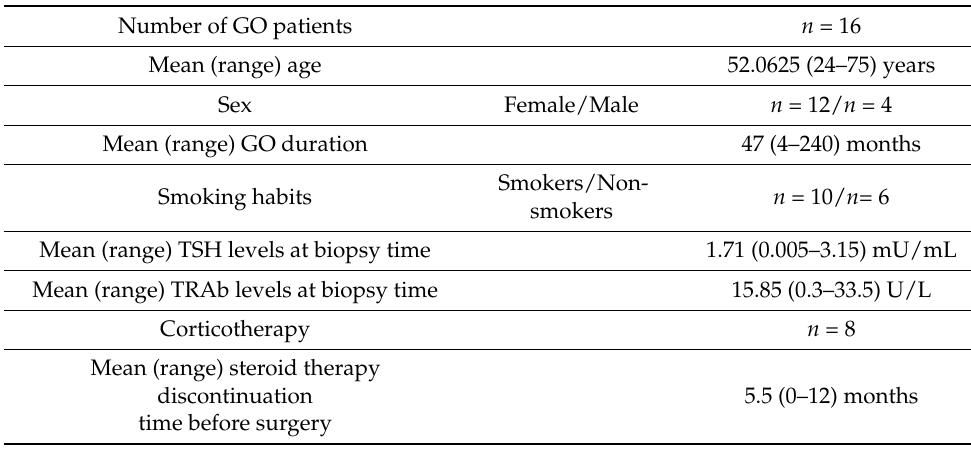
Table 2. Characteristics of patients with GO included in this